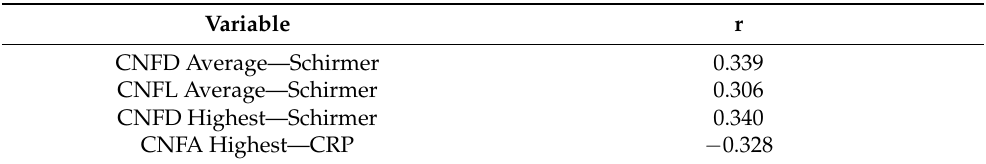
Table 3. Correlation coefficient values for the variable pairs in the correlations. For all cases, correla- tion was significant ( p < 0.05).